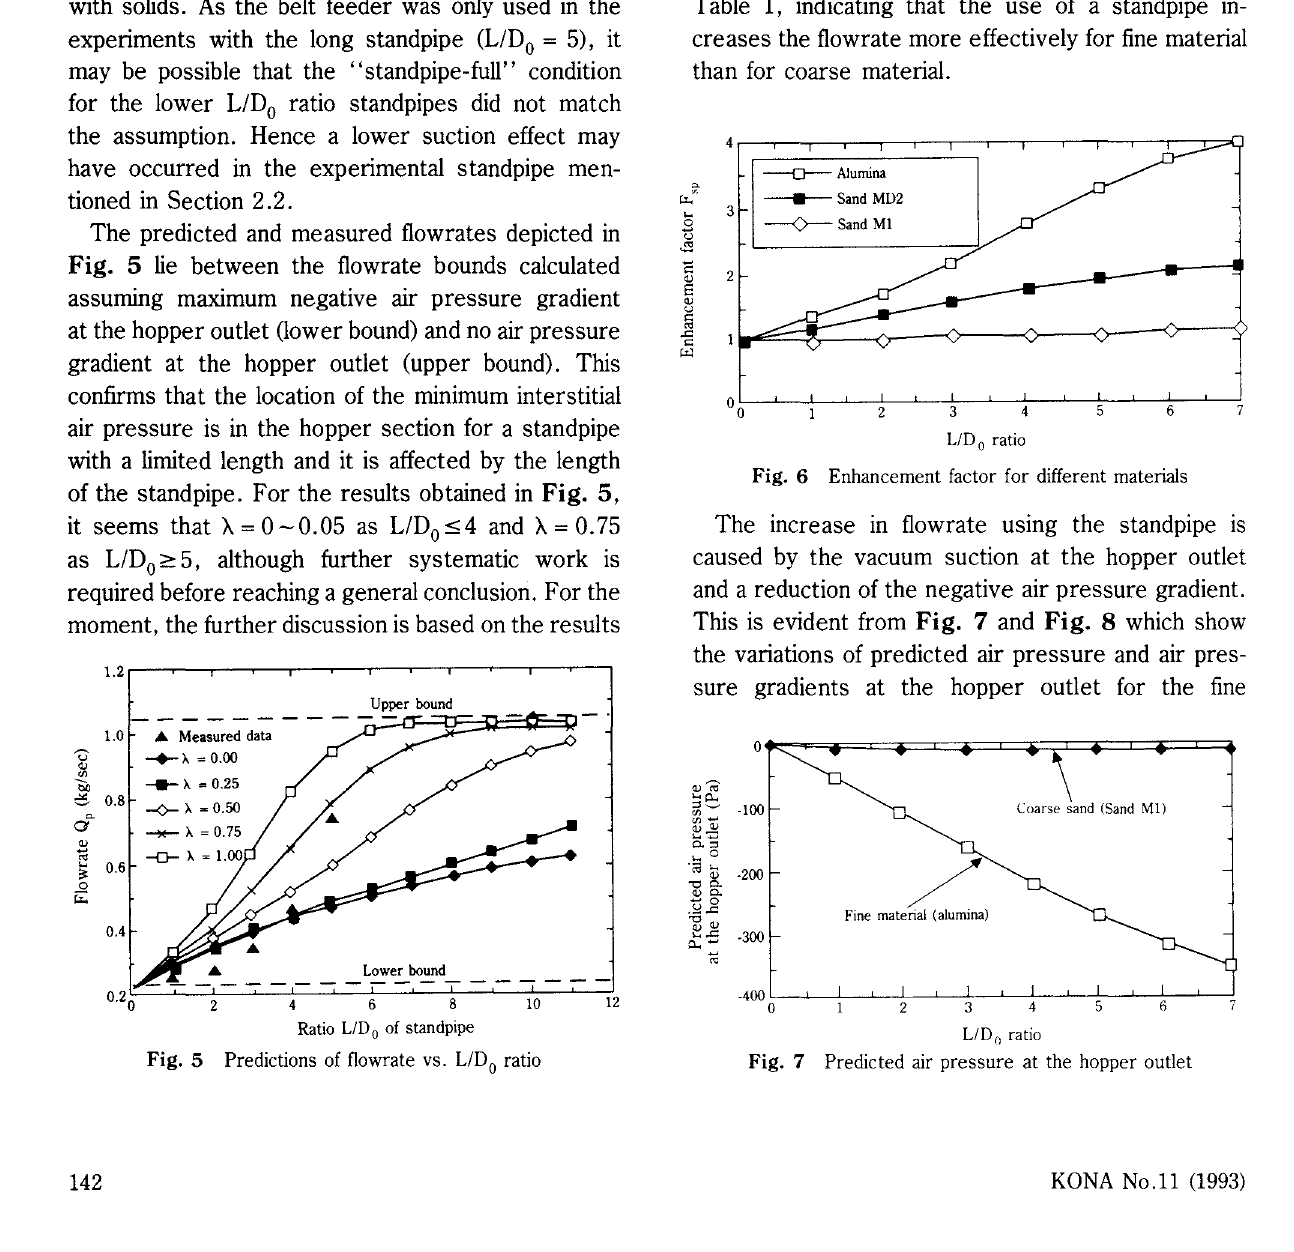
Fig. 5 Predictions of flowrate vs. LID